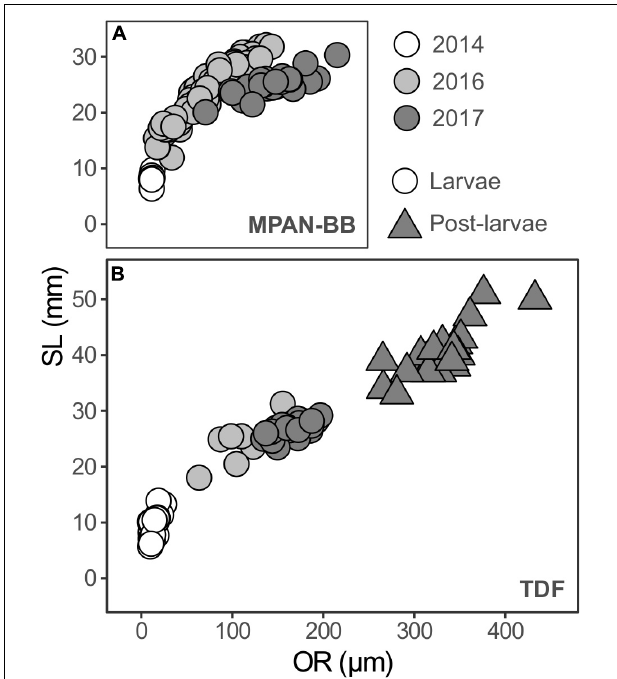
FIGURE 3 | Otolith radius (OR; µ m) and standard length (SL; mm) relationships of Fuegian sprat Sprattus fuegensis in the Southwest Atlantic Ocean. Data is differentiated according to developmental stage, the survey in which sprats were captured and the habitat sampled: the Marine Protected Area Namuncurá-Burdwood Bank (MPAN-BB) (A) and Tierra del Fuego (TDF) (B)